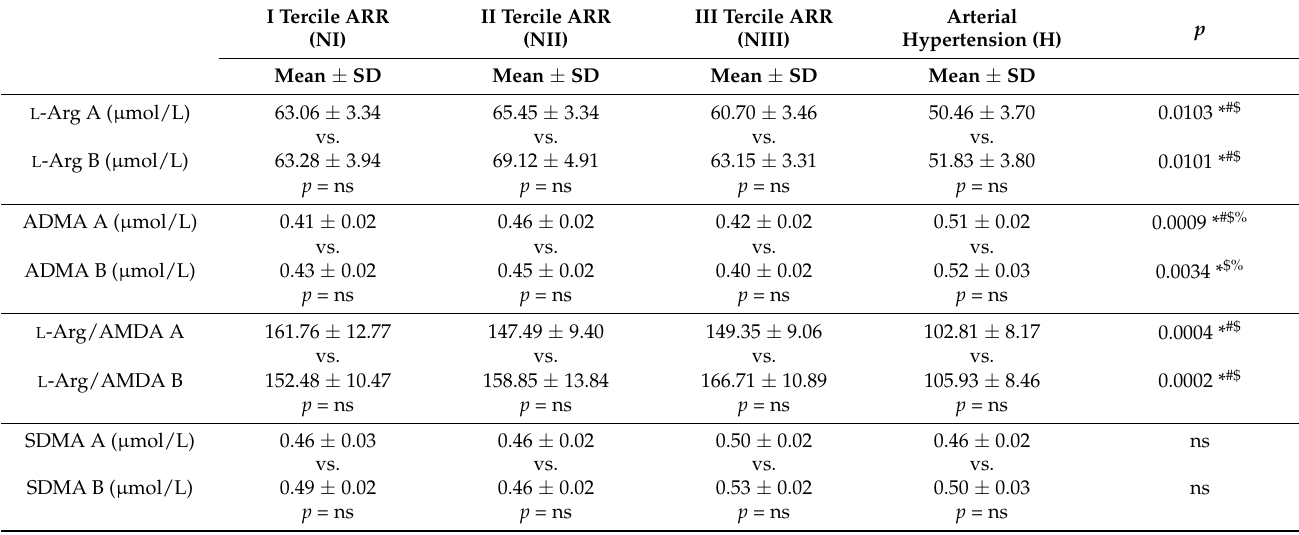
Table 3. Comparison of the nitric oxide bioavailability parameters between groups and within the same subgroup at particular steps of the study